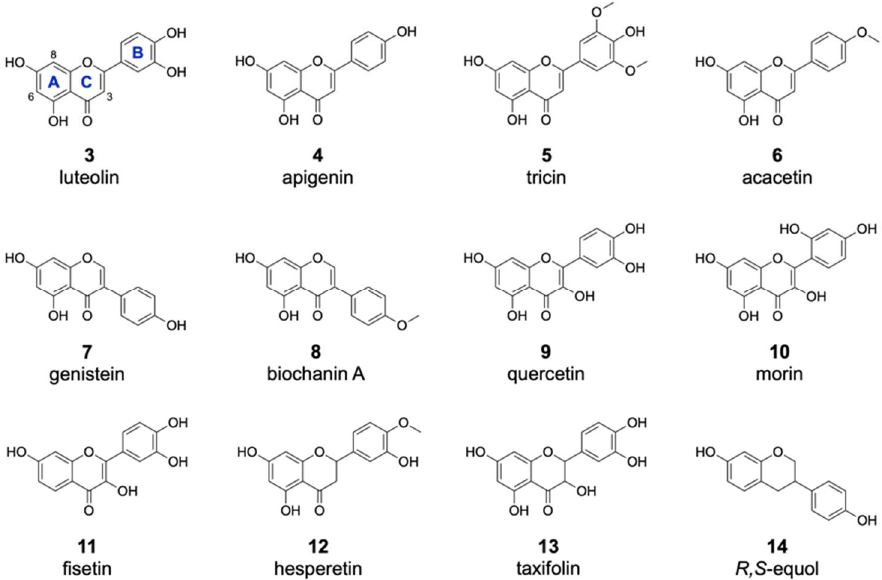
Figure 3. Substrates accepted by the halogenase DklH. The flavonoid substrates are listed according to structural groups: flavones ( 3 – 6 ), isoflavones ( 7 , 8 ), flavonols ( 9 , 10 , 11 ), a flavanone ( 12 ), a flavanonol ( 13 ) and an flavandiol ( 14 ).